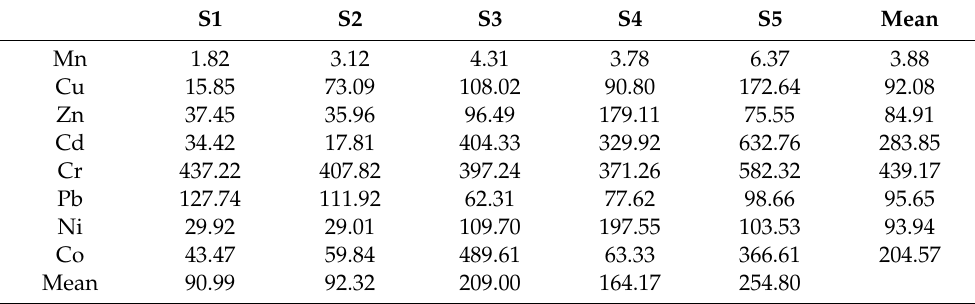
Table 3. Enrichment factor (EF) assessment data of metals in